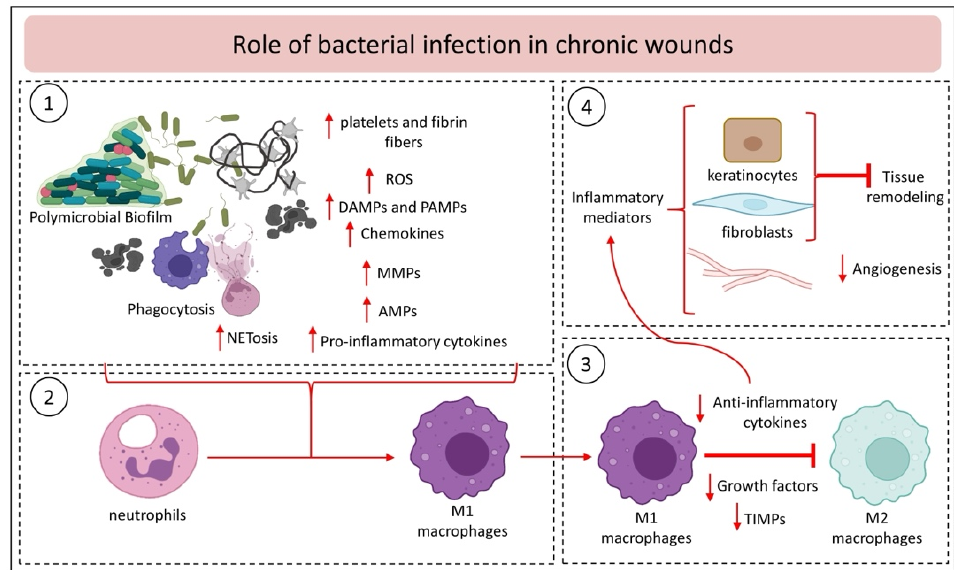
Figure 4. Role of bacterial infection in chronic wounds during the four phases of wound healing. Excessive inflammation is the main cause of chronicity and disruption of normal healing phases ((1) homeostasis, (2) inflammation, (3) proliferation, and (4) tissue remodeling phase; see text in Section 2. Chronic wounds). This inflammation is maintained by chronic activation of the innate immune system, which is driven by its interactions with and responses to polymicrobial biofilms formed within the wound. The response of the innate immune system (see Figure 3) is tightly coupled to the release of soluble mediators like reactive oxygen species (ROS), pro-inflammatory cytokines, chemokines, matrix metalloproteinases (MMPs), and antimicrobial peptides and proteins (AMPs), as well as damage-associated molecular patterns (DAMPs), pathogen-associated molecular patterns (PAMPs), neutrophil extracellular traps (NET)-osis, and the tissue inhibitor of metalloproteinases (TIMPs). This tight interplay between bacterial infection and immune responses is the major causes of chronic inflammation that prevents the initiation of the proliferative phase of healing.